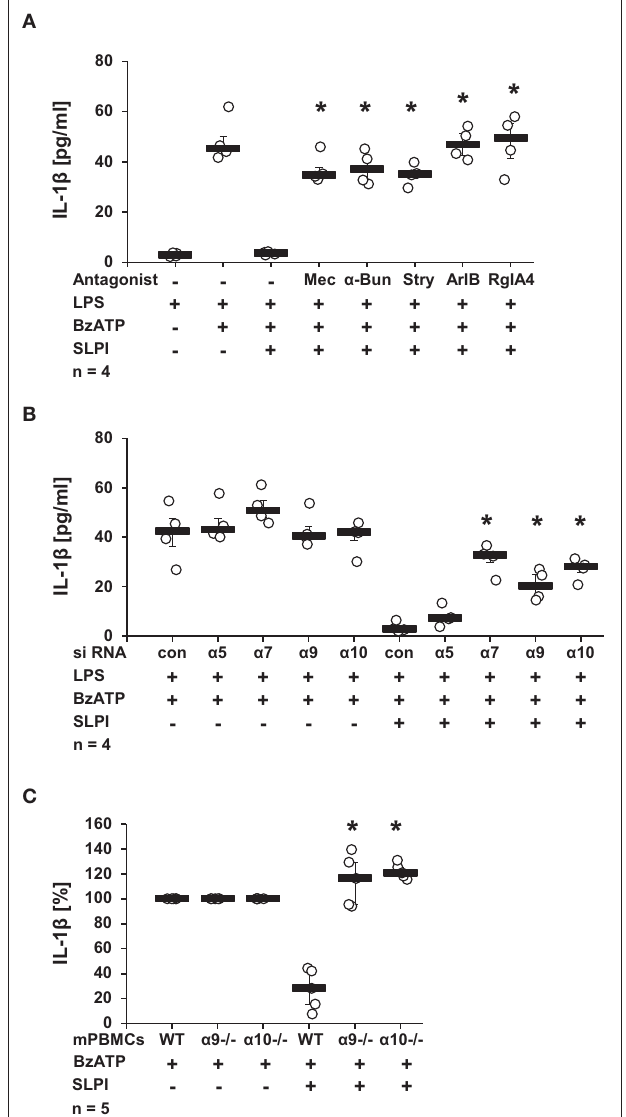
FIGURE 6 | SLPI signaling involves nicotinic acetylcholine receptor (nAChR) subunits α 7, α 9, and α 10. Human monocytic U937 cells were primed with LPS (1 µ g/ml, for 5h) and further stimulated with 2 ′ (3 ′ )-O-(4-benzoylbenzoyl)adenosine 5 ′ -triphosphate triethylammonium salt (BzATP; 100mM) for 30min. (A) Application of nicotinic antagonists mecamylamin (Mec), α -bungarotoxin ( α -Bun), strychnine (Stry), RgIA4, or ArIB abolished the SLPI-mediated inhibition of BzATP-induced IL-1 β release; * p ≤ 0.05 significantly different compared to cells stimulated with LPS, BzATP, and SLPI. (B) Down-regulation of the expression of nAChR subunits α 7, α 9, or α 10 by siRNA blunted the SLPI-induced inhibitory mechanism. * p ≤ 0.05 significantly different compared to cells transfected with control siRNA (con) and stimulated with LPS, BzATP and SLPI. (C) Mouse peripheral blood mononuclear cells (mPBMCs) deficient in α 9 or α 10 nAChR subunits stimulated with BzATP were resistant to the SLPI-mediated inhibition. The amount of IL-1 β released upon stimulation with BzATP was set to 100% and the remaining values were calculated accordingly. * p ≤ 0.05 significantly different compared to mPBMCs obtained from wild-type (WT) mice stimulated with BzATP and SLPI. Experimental groups were compared by Kruskal-Wallis test followed by Mann-Whitney rank sum